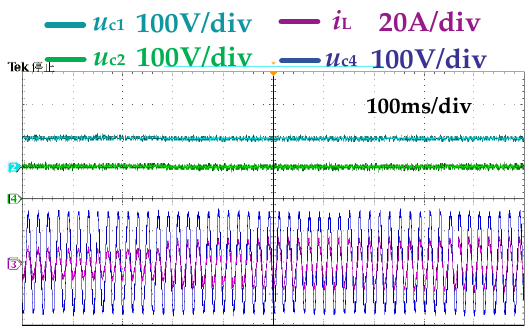
Figure 14. Experimental results of current i L and voltages u s , u c1 and u c2 with load suddenly changing from 100 Ω to 50 Ω.